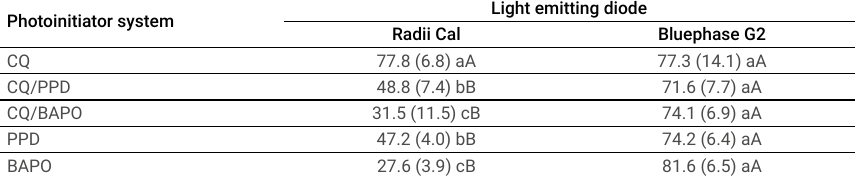
Table 3. Degree of conversion (%) means (standard-deviation) of dental adhesive systems according to the photoinitiator system and the curing